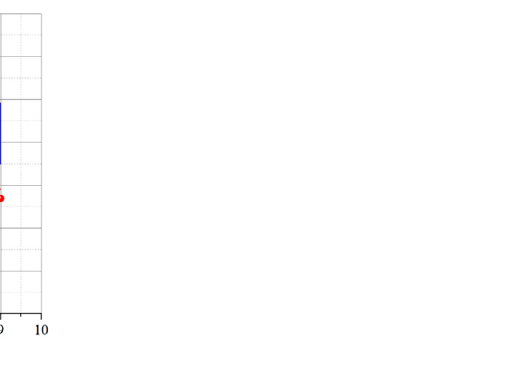
Figure 9. The entire deformation process of the crushed rock sample with skeleton load-bearing effect. The periodic axial stress-strain curves of the crushed mudstone samples at each loading stage were presented in Figures 10–12. From these figures, we known that the periodic axial strain of the crushed mudstones was composed of instantaneous deformation and creep deformation. Observations of the instantaneous axial strain and axial creep strain of crushed mudstones at each loading stage were listed in Tables 2 and 3 respectively. Table 2 showed that the instantaneous axial strain of all samples decreased with increasing loading stage. From observations in Table 3, we know that the axial creep strain of sample S-1 at each loading stage was approximately similar, and most of them were between 0.7–0.8. But for sample S-2 and S-3, the axial creep strain was a minimum at the skeletal load-bearing stage. As it entered the crushing cum filling stage, the periodic creep deformation increased sharply. Table 2. The periodic axial instantaneous strain of crushed mudstone samples at each loading stage. The Periodic Axial Instantaneous Strain ε 1 (%) Particle Size